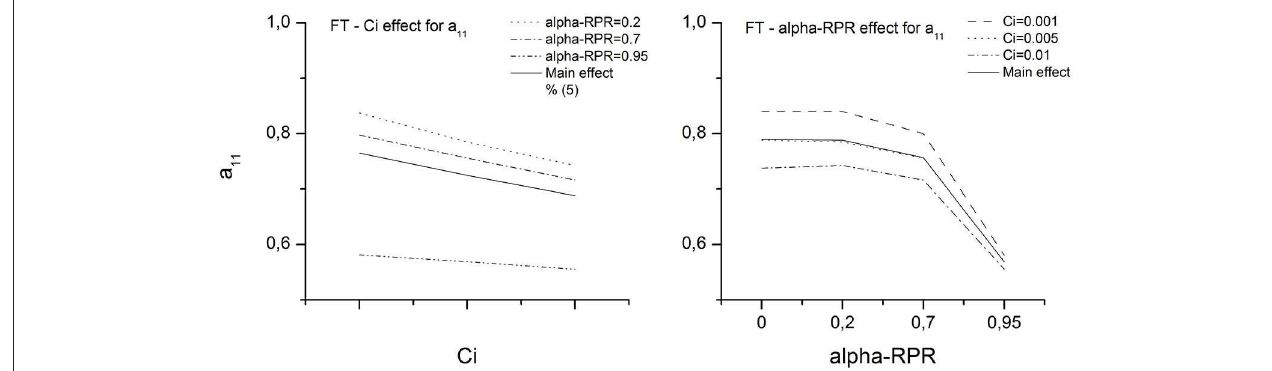
FIGURE 8 | Main effects and interaction of the FT-RPR model parameters.